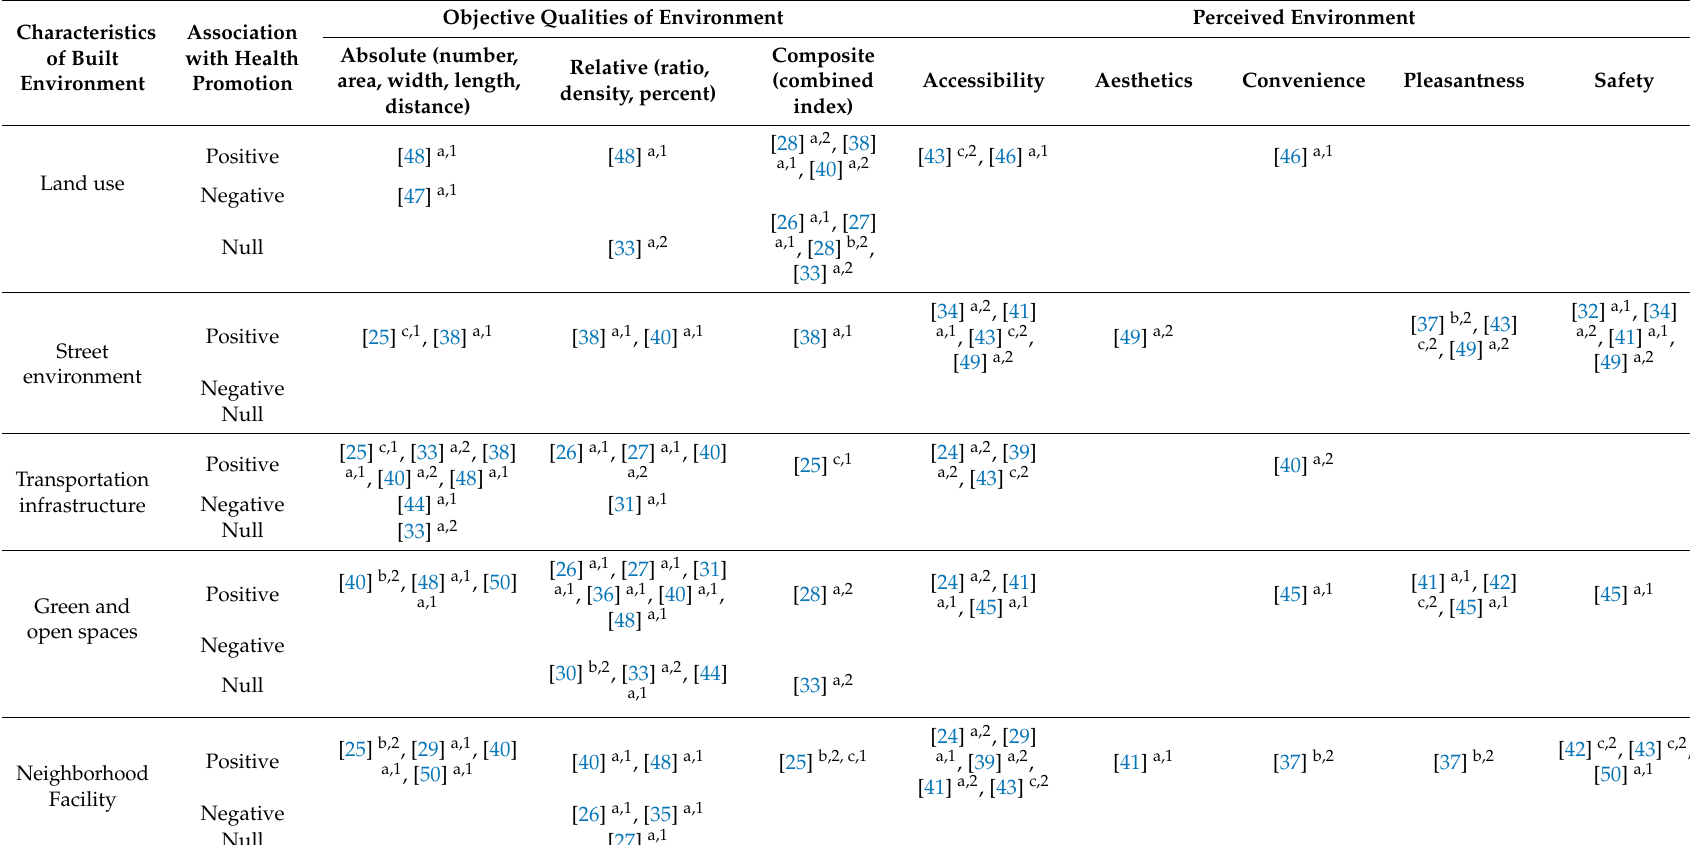
Table 4. Associations between the built environment characteristics and health-related